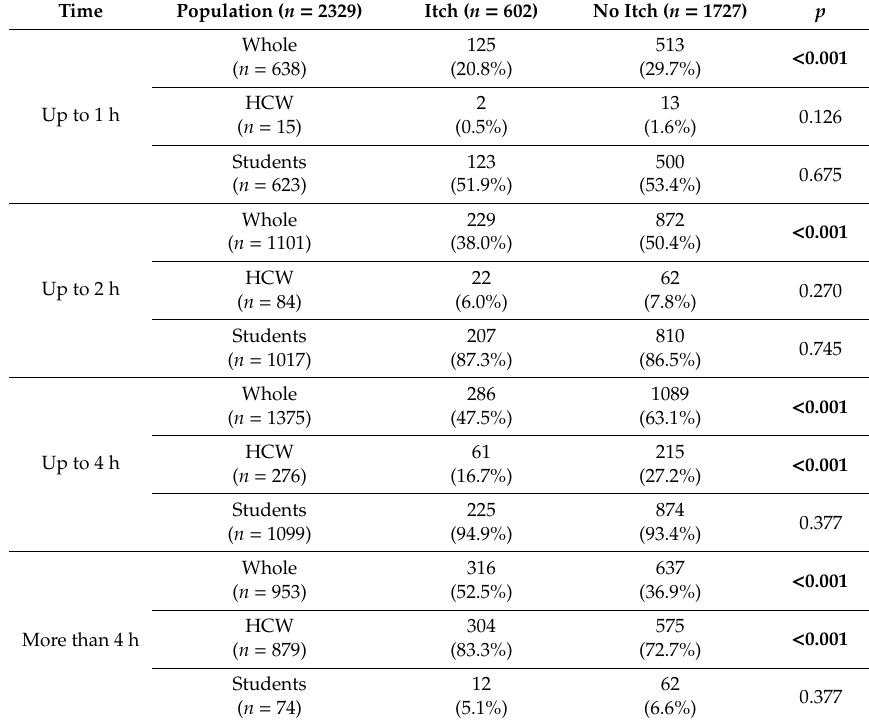
Table 4. Severity in relation to the duration of face mask use.